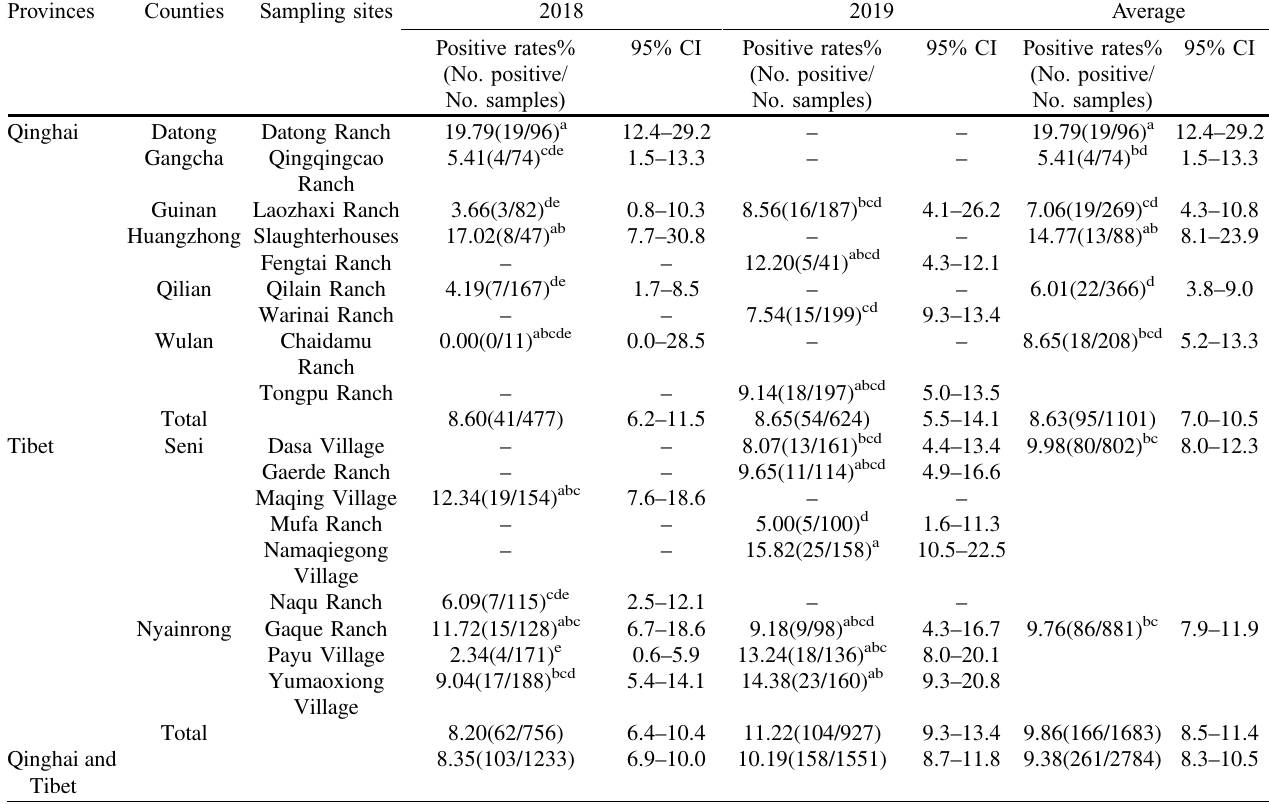
Note: The same lowercase letters within columns represent no signi fi cant differences between groups ( p > 0.05) and different lowercase letters within columns represent signi fi cant differences between groups ( p <